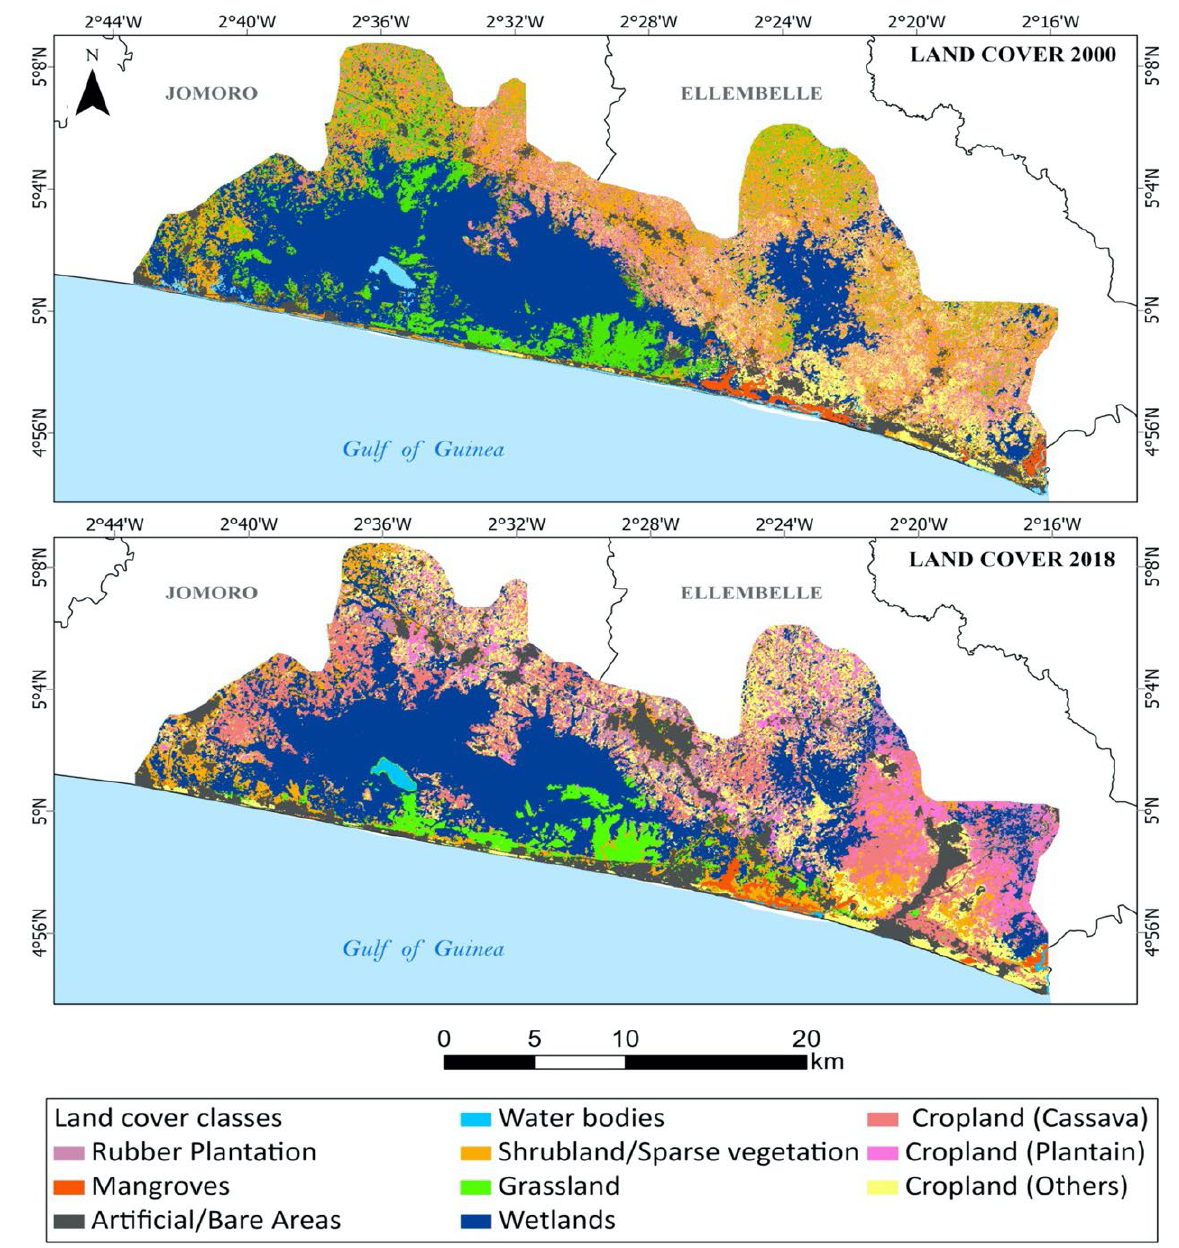
Figure 3. Land use/land cover types in the study area .